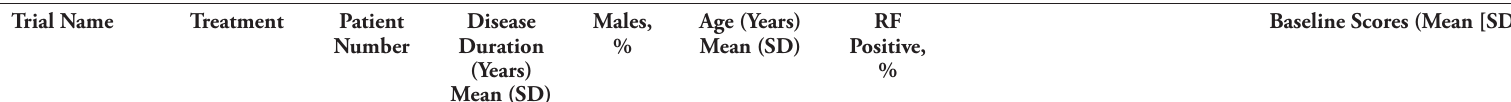
Table 1. Population characteristics: